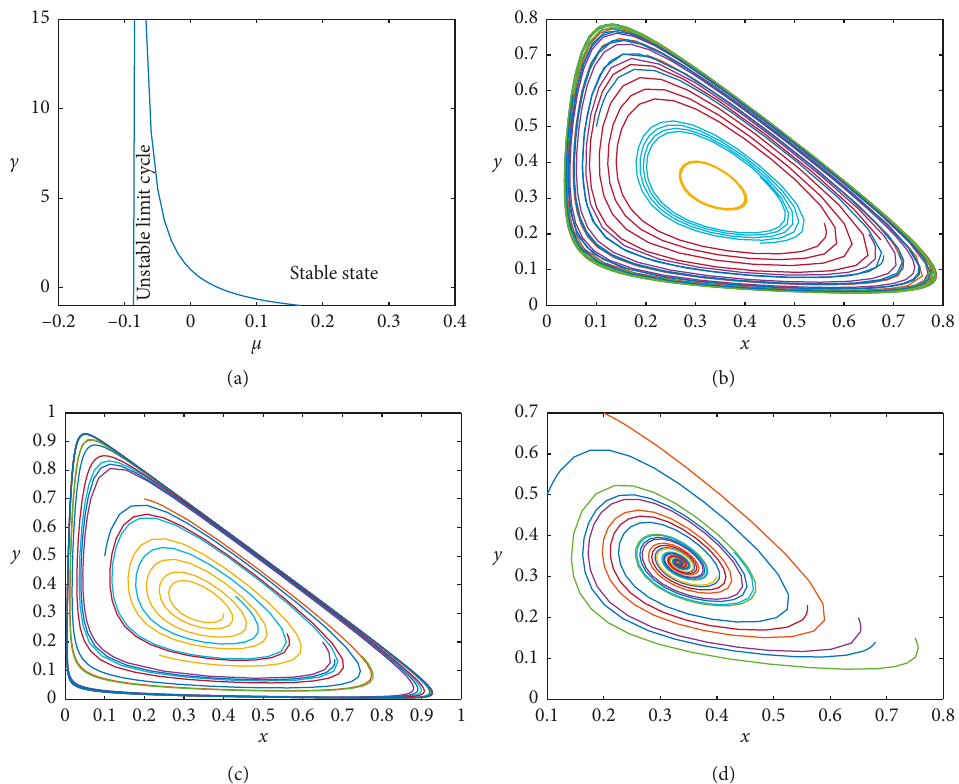
Figure 5: (a) The stability and limit cycle with different c and μ (Hopf curve). (b) When c � 0 . 8and μ � 0 . 00595, the limit cycle occurs around x ∗ . (c) When c � 0 . 8and μ � 0 . 002, the interior equilibrium is unstable. (d) When c � 0 . 8and μ � 0 . 02, the interior equilibrium is stable.